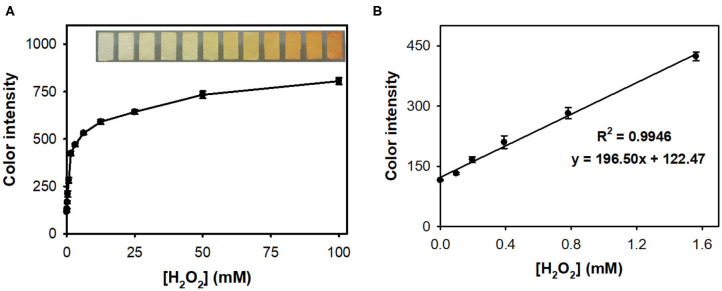
(A) Real images and the corresponding dose-response curve for H2O2 determination using nanoceria-embedded paper strip and (B) linear calibration plot. The error bars represent the standard deviation of three independent measurements.